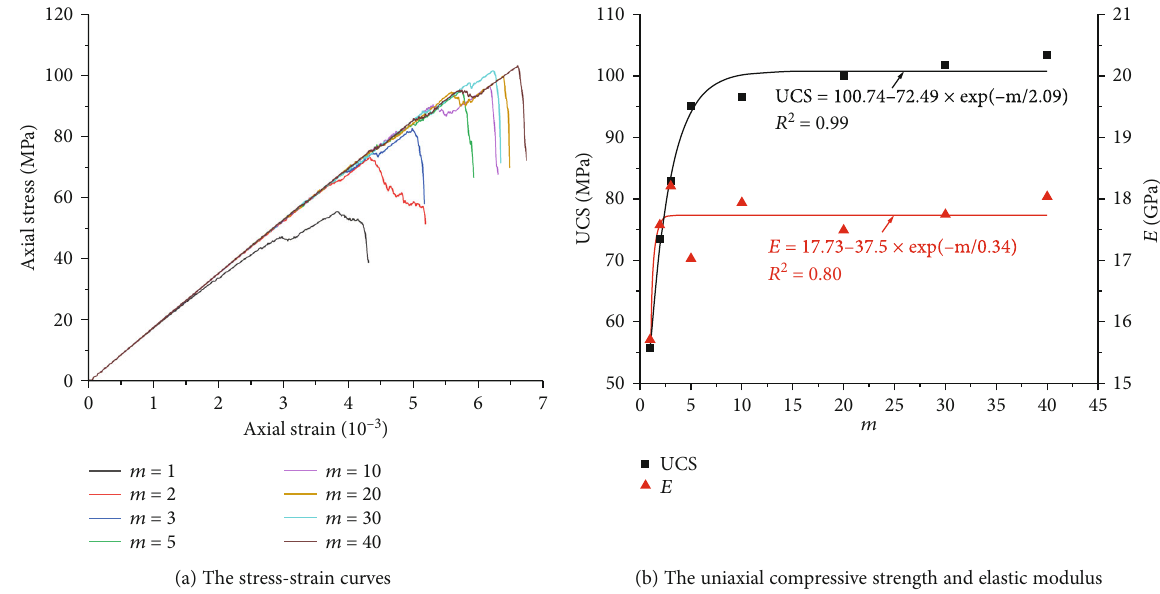
Figure 16: Relationship between macromechanical properties and homogeneity factor of m